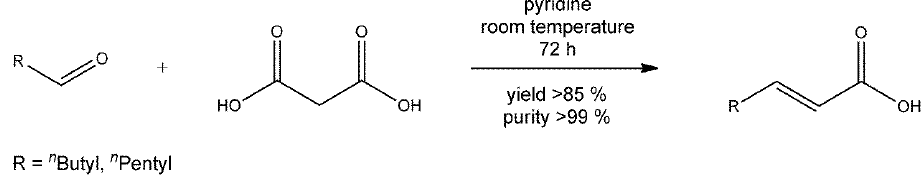
Scheme 1. Reaction sequence for the synthesis of the two title compounds— C7 and C8 .